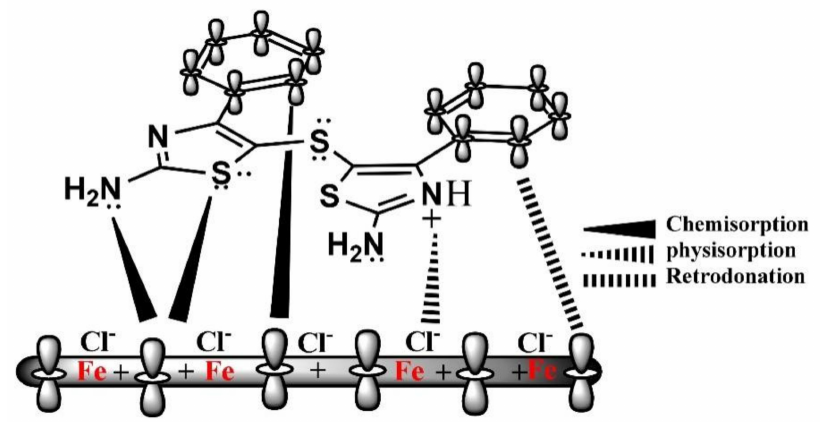
Figure 1. Diagrammatic illustration of the three adsorptions (physisorption, chemisorption, and retro-donation mechanisms) of organic corrosion inhibitors (DHATs). (Reprinted with permission from Ref. [45]. Copyright 2015 Elsevier